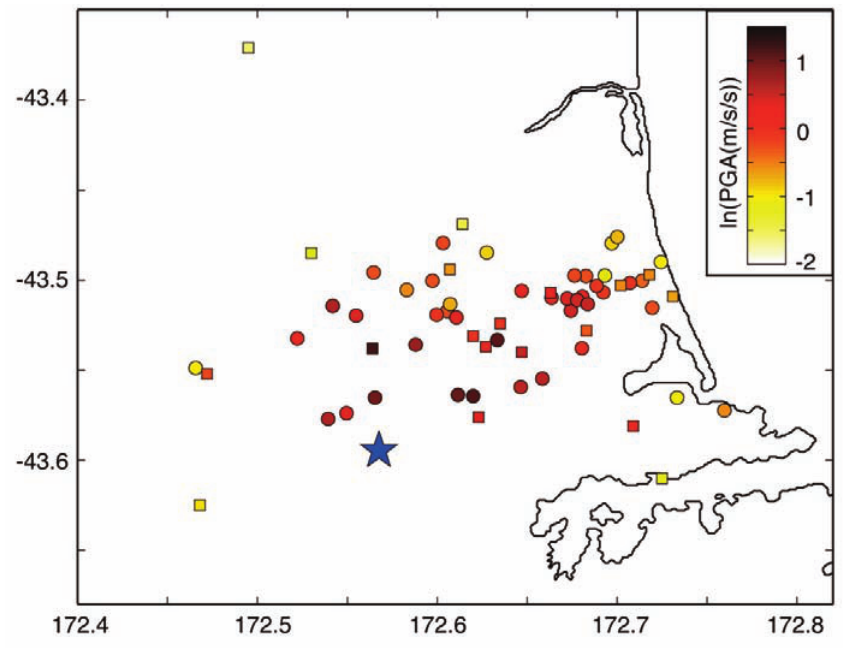
Figure 2. Peak horizontal ground acceleration (PGA ) recorded by QCN (circles) and GeoNet (squares) stations during a M5.1 aftershock on October H 18, 2010 (blue star). The stations are colored by observed PGA. Note that a few (<3) of the QCN stations have IP-based locations that are not very accurate. We included those data here for completeness; although the location quality is included in the metadata so the data could be